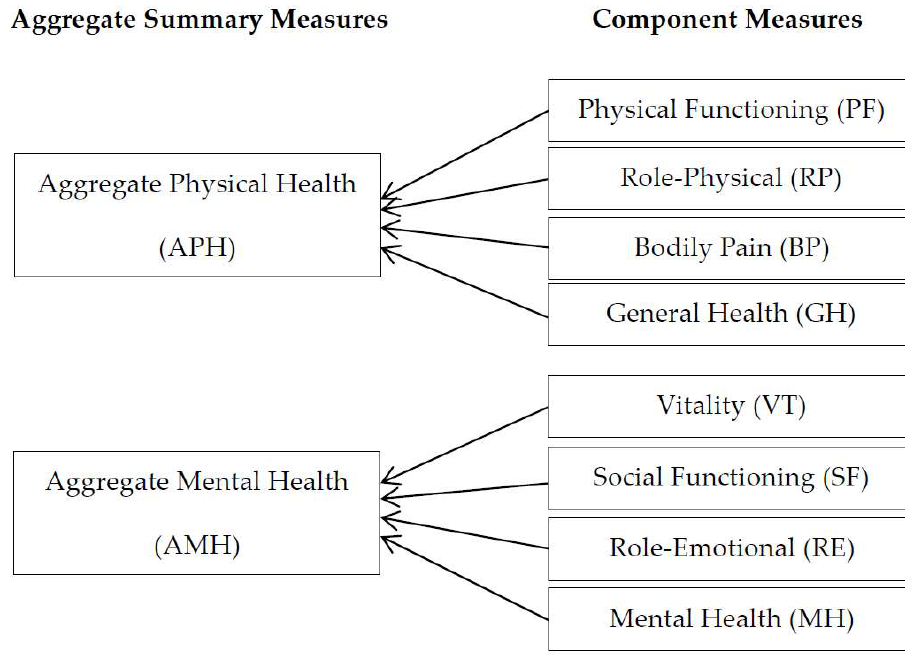
Figure 1. Aggregate health measures and related submeasures.